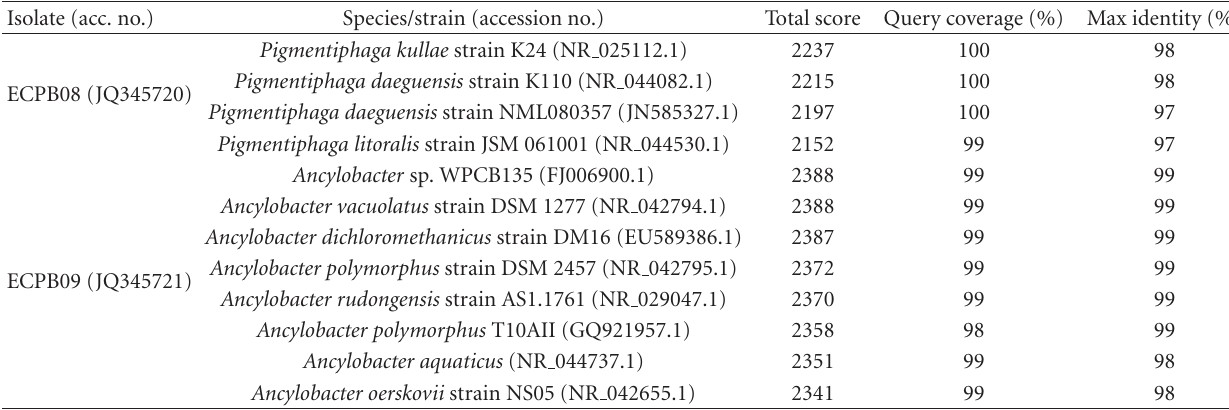
Table 1: Local alignment results for fluoroacetate-degrading bacterial isolates 16S rRNA sequences. Sequences were compared to those deposited at the National Center for Biotechnology Information using the regular BlastN algorithm available at http://www.ncbi.nlm.nih .gov/BLAST. Organisms with sequences similar to those of isolates ECPB08 (JQ345720) and ECPB09 (JQ345721) are listed on the second column. Values for the parameters total score, query coverage, and maximum identity are displayed in columns 3 to 5. GenBank access codes are displayed in